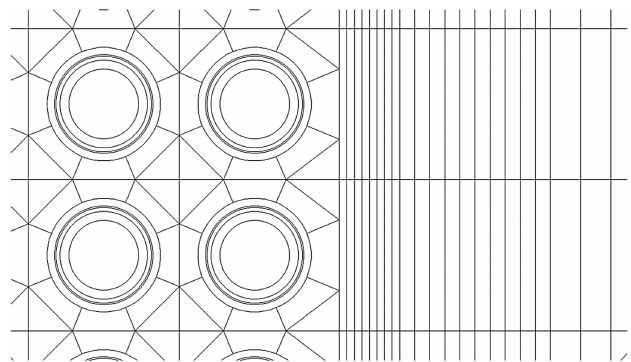
Fig. 1. Spatial core mesh: interface between the peripheral assemblies and the